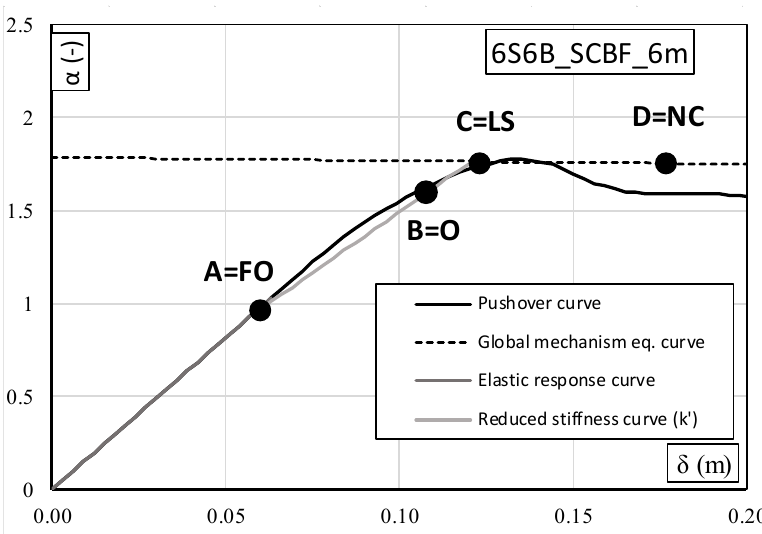
Figure 8. Trilinear model and characteristic points for the structure 6S6B_SCBF_6 m.